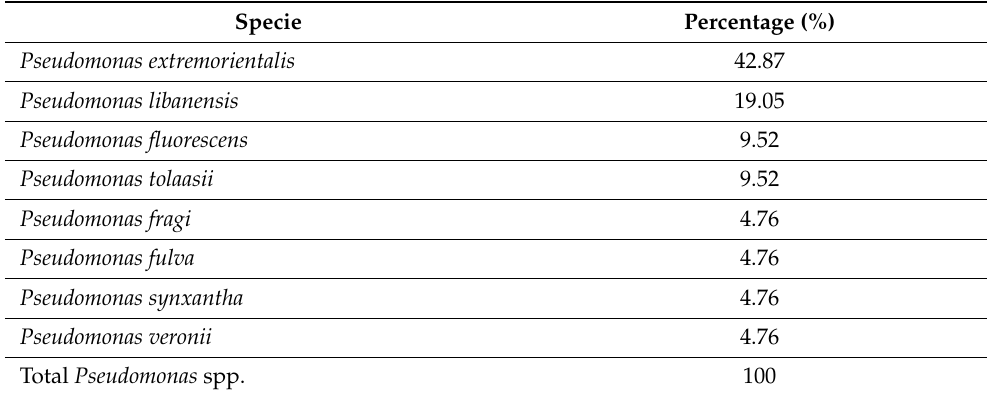
Table 2. Percentage of Pseudomonas spp. isolated from chromogenic agar in fresh goat meat free of antibiotic residues.